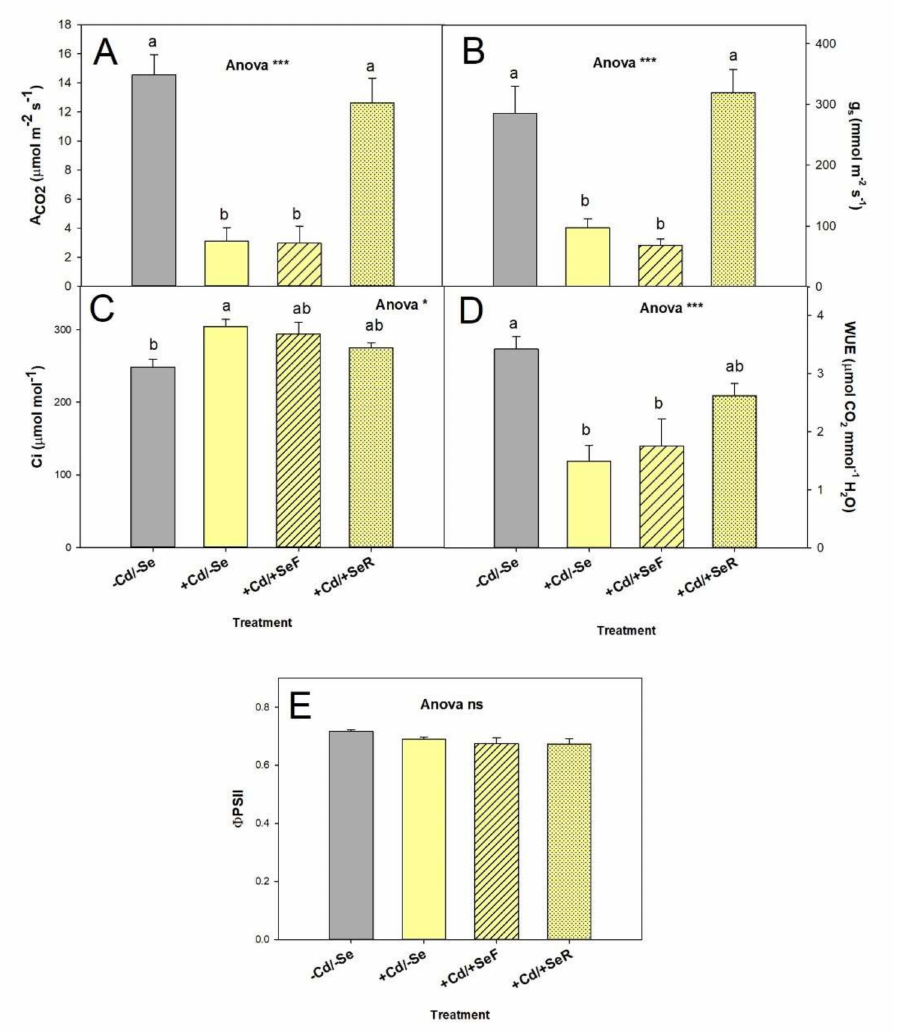
Figure 3. Net assimilation rate of CO 2 (ACO 2 , µ mol m − 2 s − 1 ; ( A )), stomatal conductance (gs, mmol m − 2 s − 1 ; ( B )), Ci (substomatic CO 2 ; ( C )), water use efficiency (WUE, µ mol CO 2 mmol − 1 H 2 O; ( D )) and PSII (photochemical quenching of PSII; ( E )) of pepper plants under four treatments of cadmium and selenium ( − Cd/ − Se, +Cd/ − Se; +Cd/+SeF and +Cd/+SeR). In the ANOVA: “ns” indicates non-significant differences for a confidence interval of 95%; Also, * and *** indicate significant differences for p < 0.05 and 0.001, respectively. The different lowercase letters indicate significant differences between the treatments for p < 0.001 established by Tukey’s multiple range test. The standard error of the mean is also